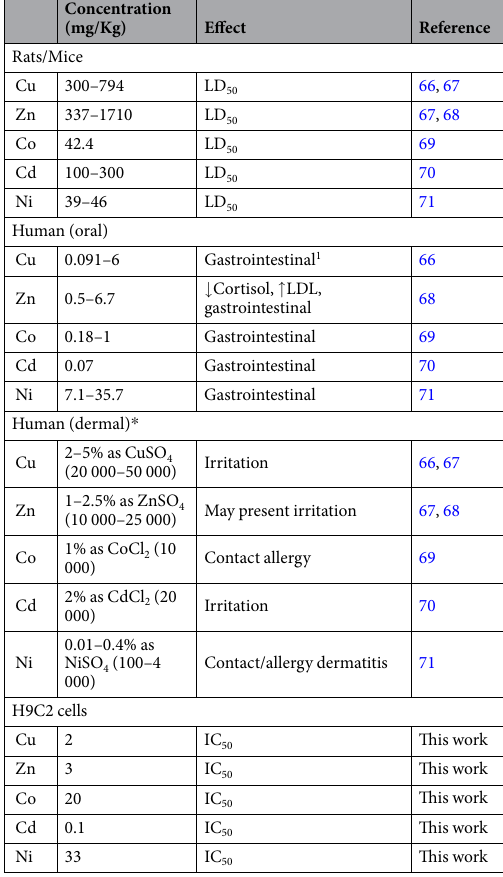
Table 2. Toxicity data of transition metals. 1 Gastrointestinal effects may include nausea, vomiting, diarrhea, abdominal cramps. * Dermal exposures expressed the metals salt reported in each